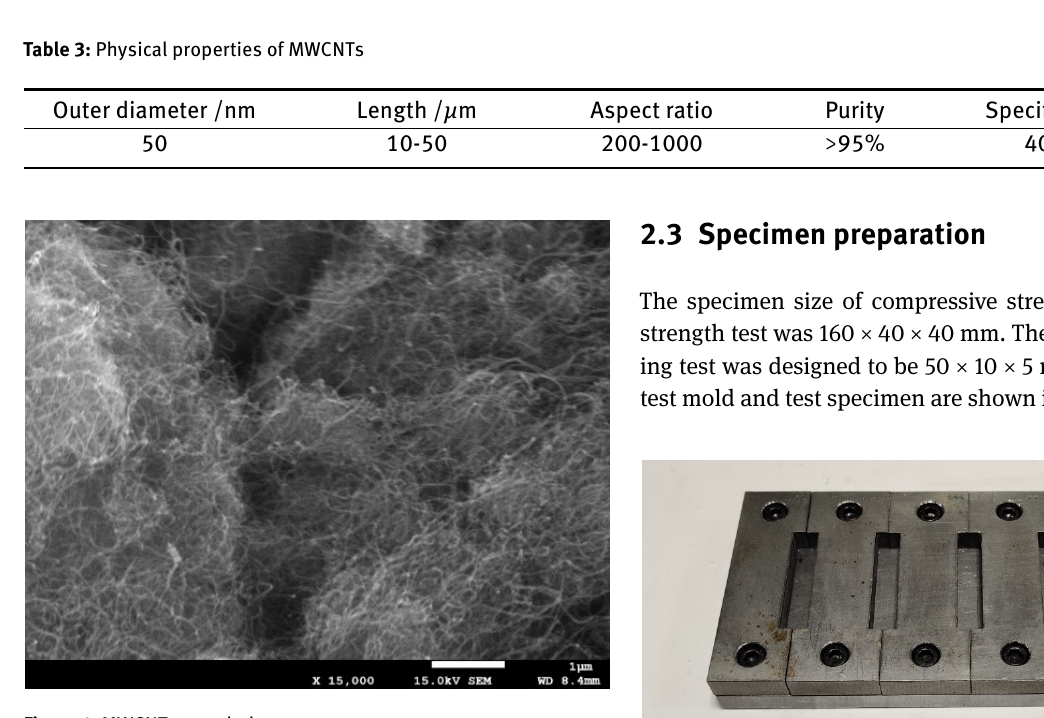
Figure 1: MWCNTs morphology